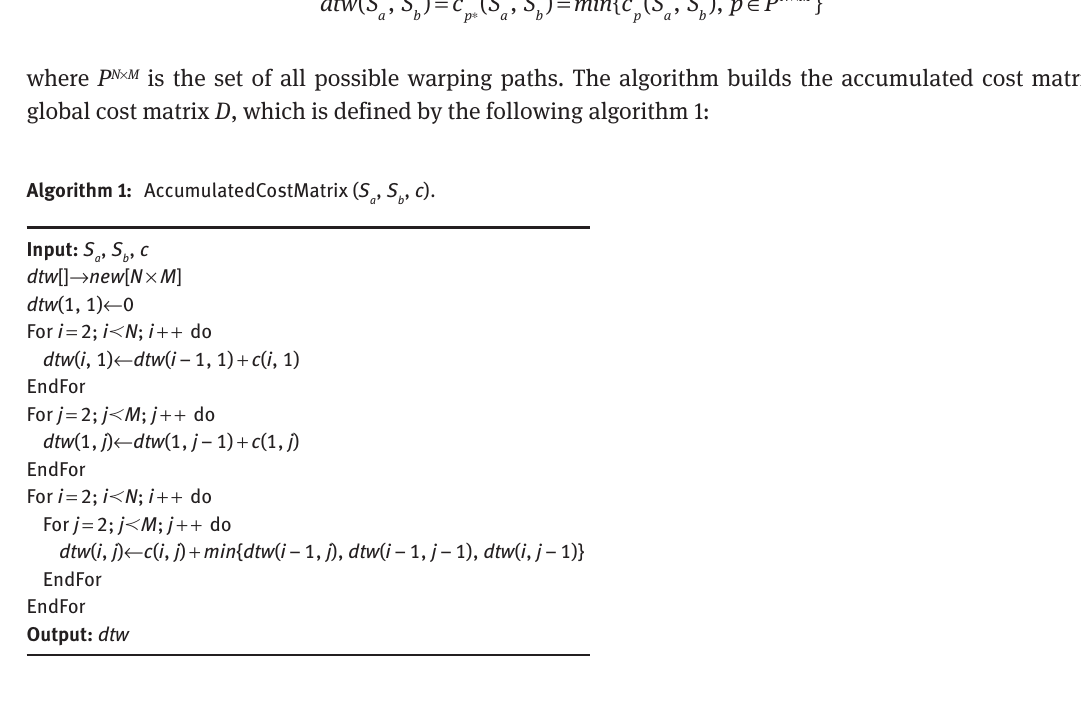
Algorithm 1: AccumulatedCostMatrix ( S